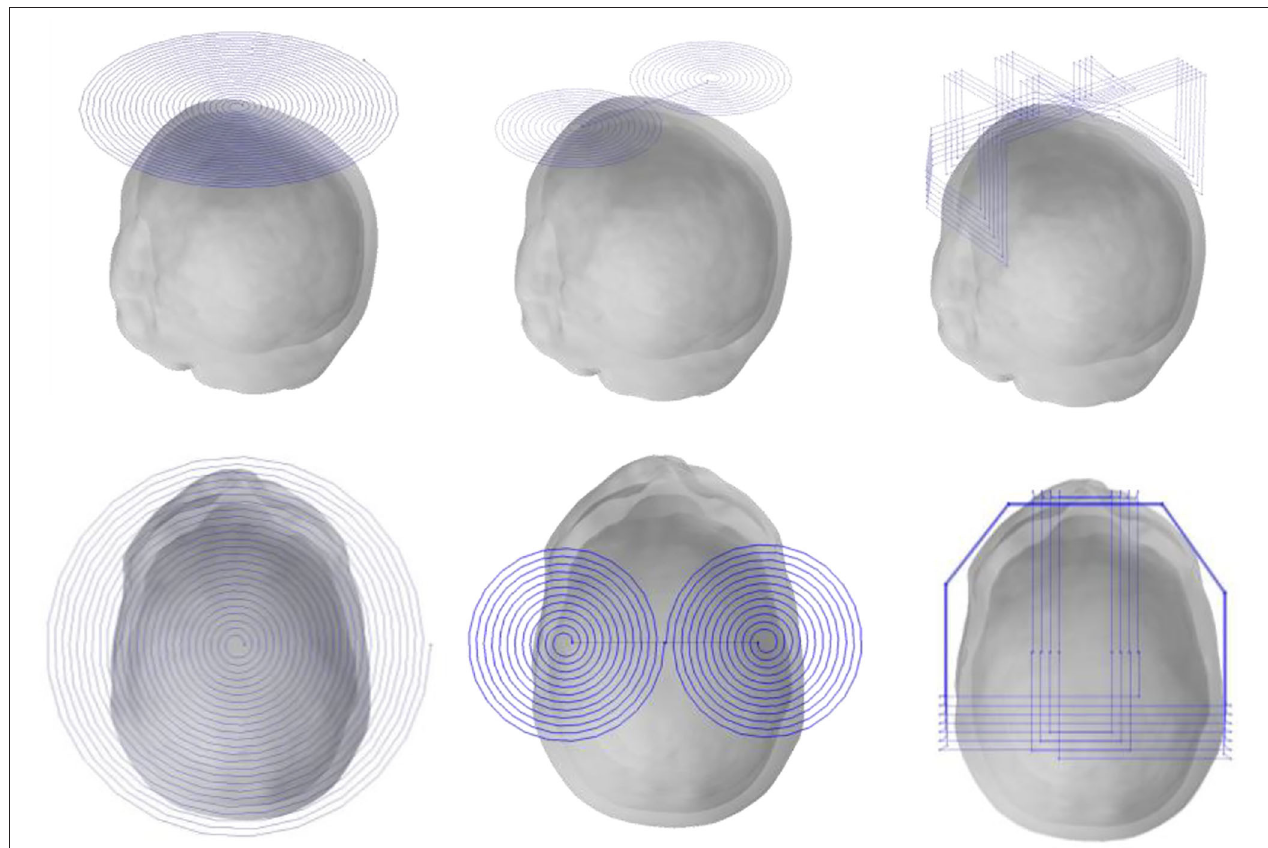
FIGURE 3 | Three different excitation coils.